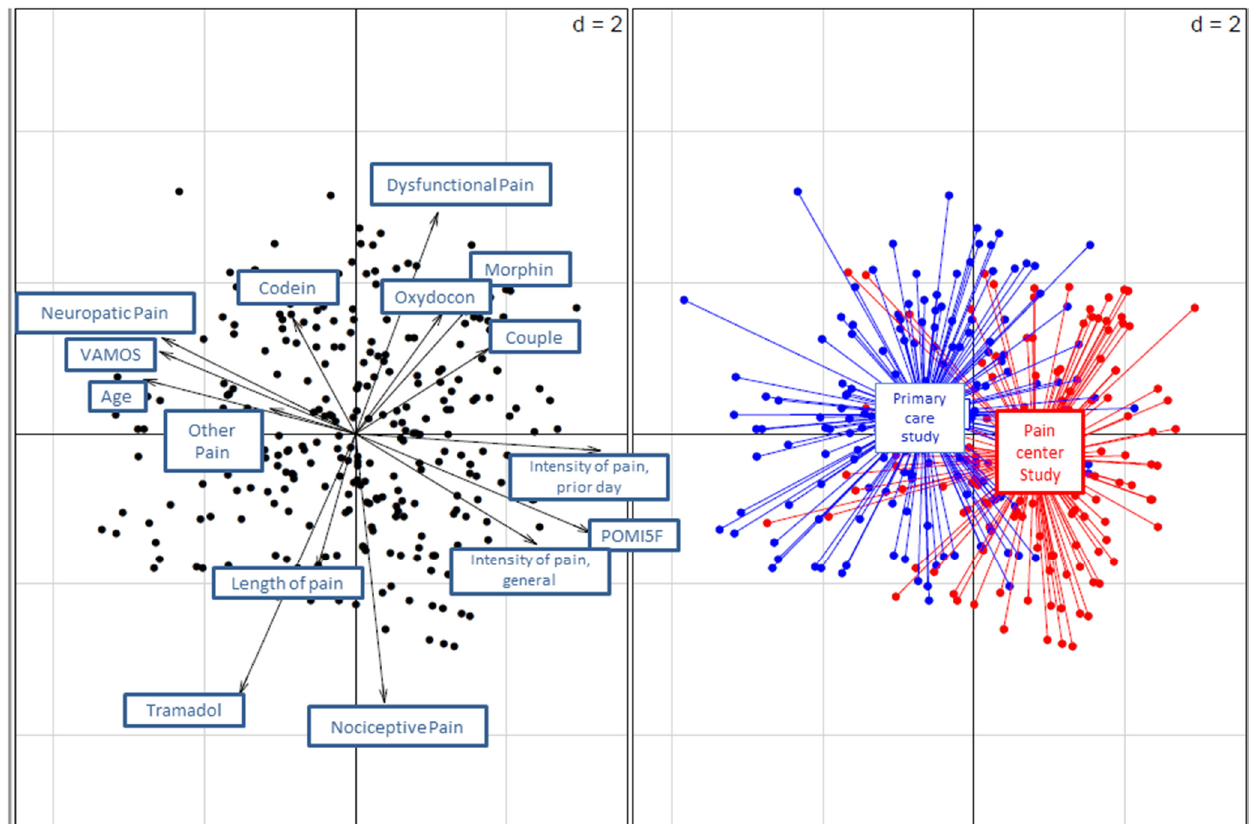
Figure 3. Distribution of the variables in the samples of the two studies: pain center and primary care.